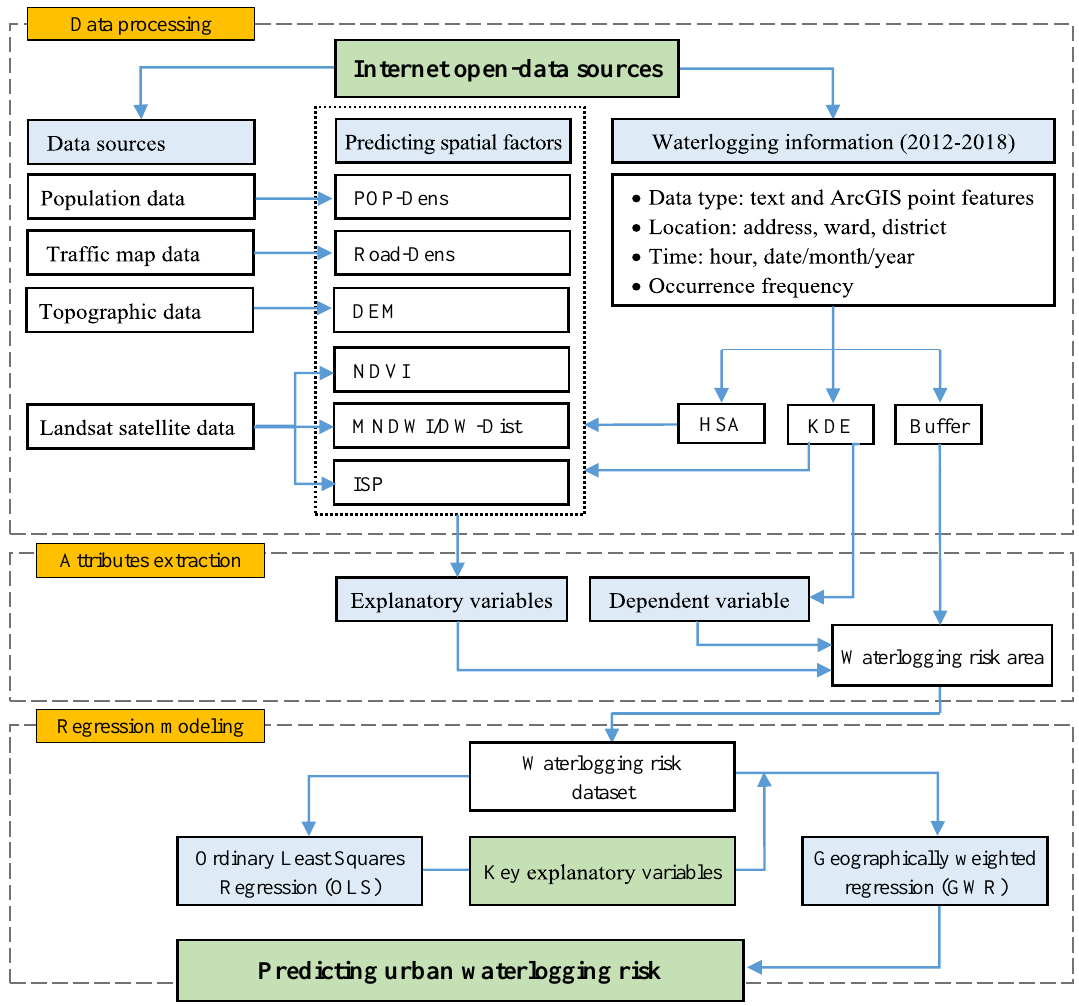
Figure 4. Integrated Framework of Regression model. Abbreviations: HSA, Hot Spot Analysis; KDE, Kernel Density Estimation.